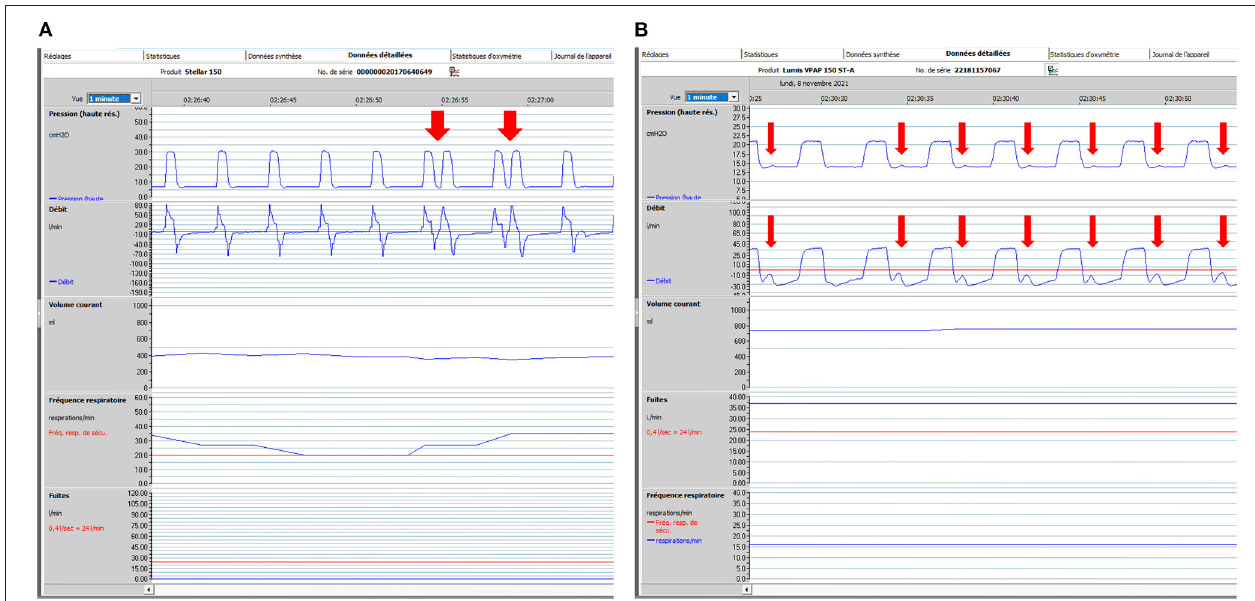
FIGURE 4 | Patient ventilator asynchrony (PVA): illustrative ventilator tracings. One-minute windows. From top to bottom: pressure, flow, tidal volume, respiratory rate and unintentional leaks (i.e., without intentional leak through exhalation valve of mask). Rescan software, ResMed. (A) 74-year-old male subject with severe COPD (FEV1: 20% of predicted). Bi-level pressure support ventilator, Rescan software, Resmed. Ventilator settings: ST (spontaneous/timed) mode; IPAP (Inspiratory positive airway pressure): 30 cmH 2 O; EPAP (Expiratory positive airway pressure): 7 cmH 2 O; BURR (back-up respiratory rate) 20 cycles/min. Red arrows show intermittent double-triggering. In this case, leaks are not in cause. Possible causes are dysfunction of ventilator, too high inspiratory trigger sensitivity, too short minimal inspiratory time (TI MIN ) with prolonged inspiratory efforts. Adjustments of settings (if required) to be considered are: to increase TI MIN ; to adapt cycling sensitivity (at a lower percentage of peak inspiratory flow, which delays cycling); to increase IPAP and reduce rise time; or to decrease sensitivity of inspiratory trigger. (B) 67-year-old